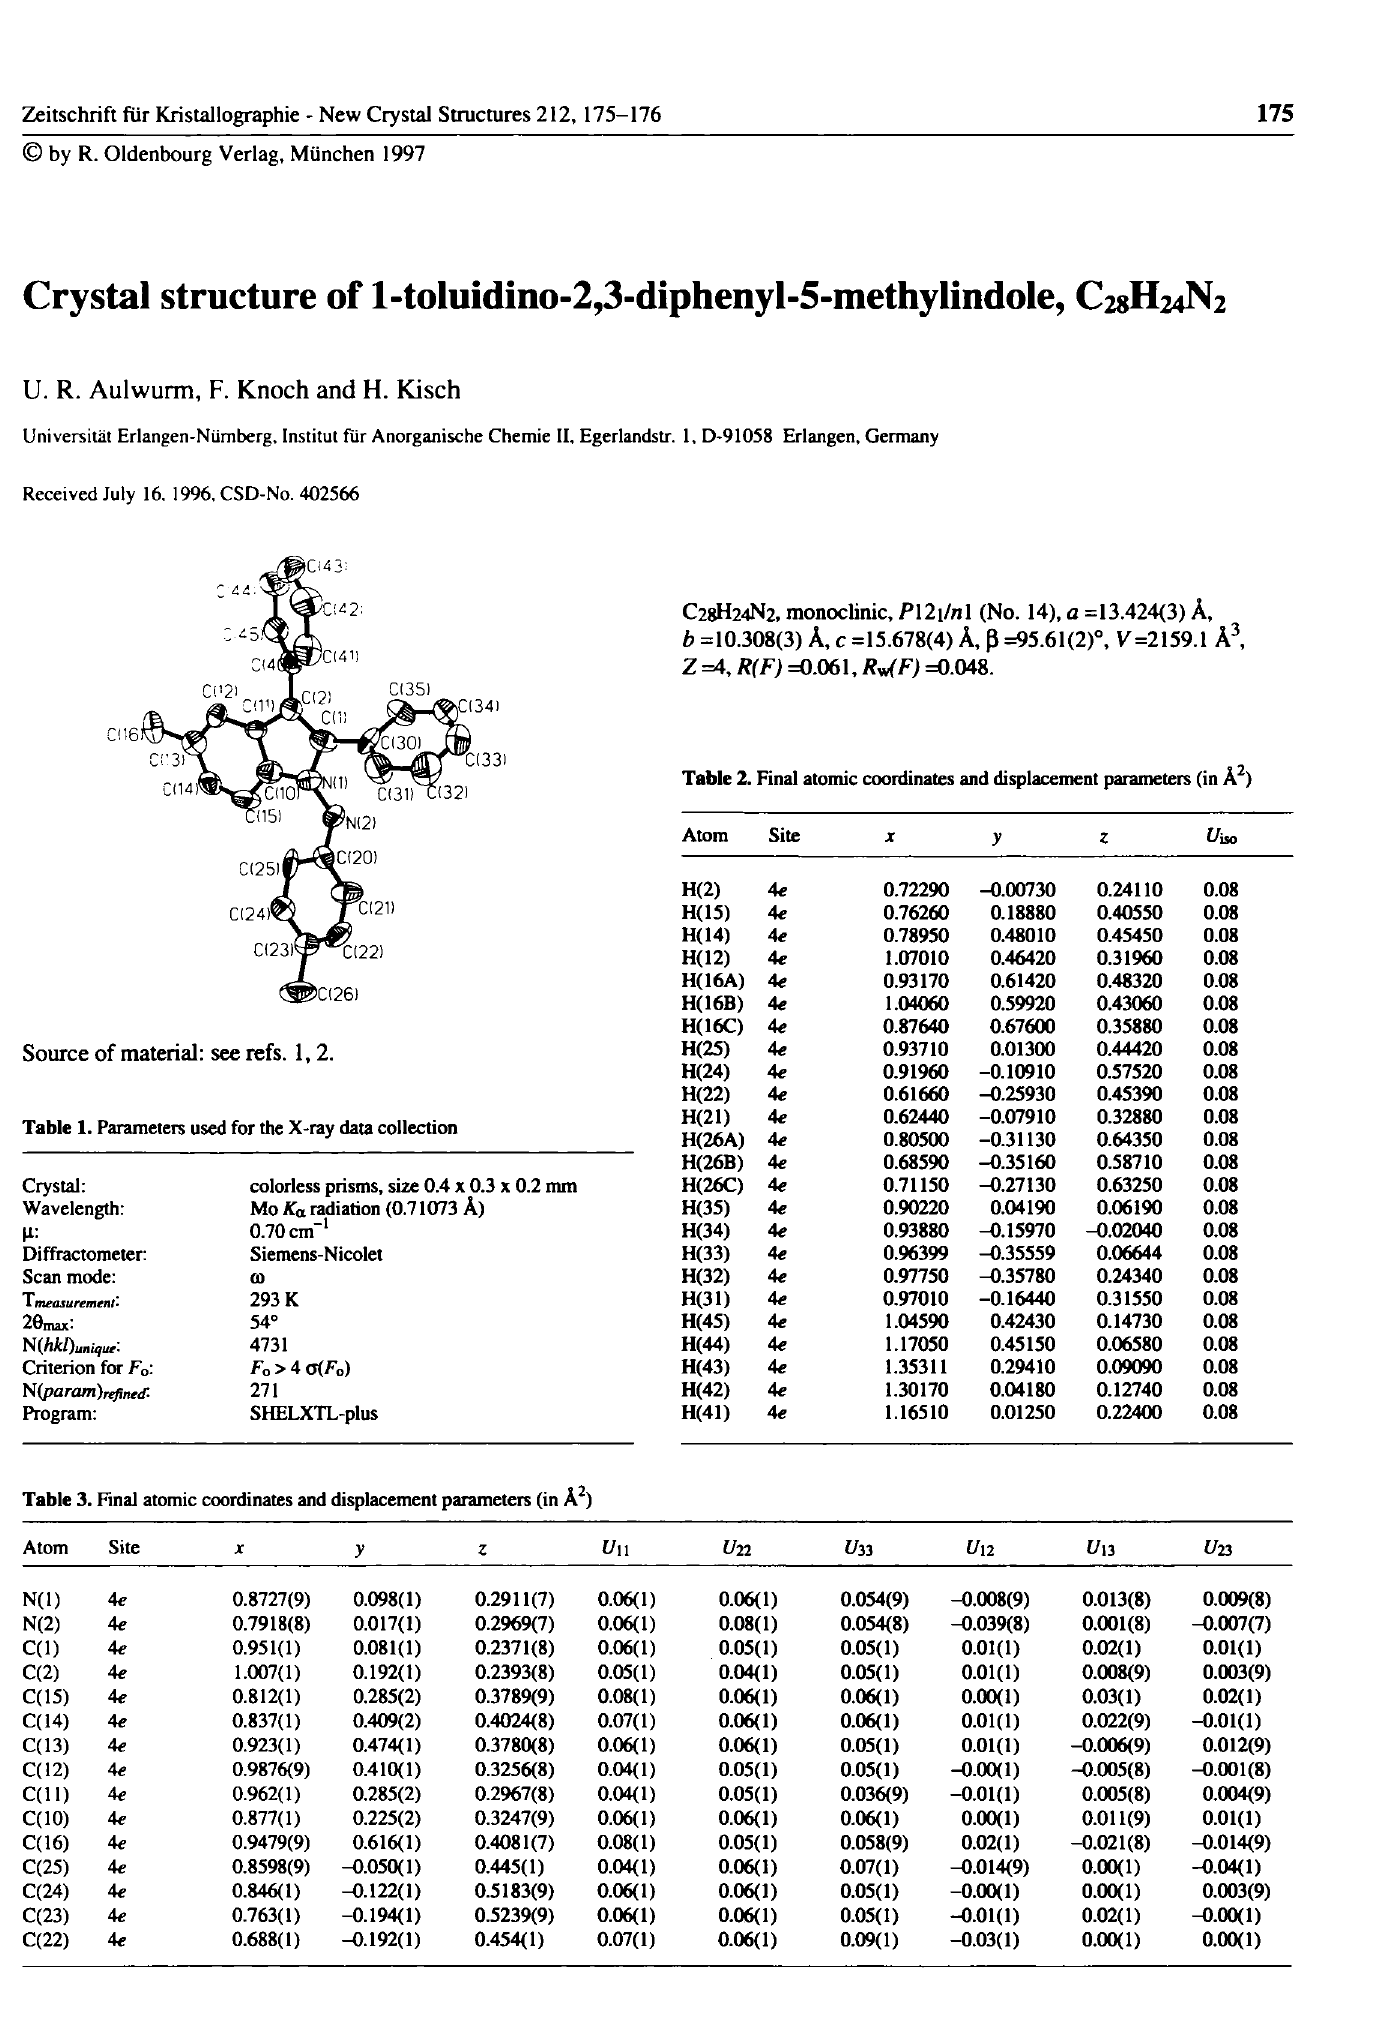
Table 2. Final atomic coordinates and displacement parameters (in Â 2 )